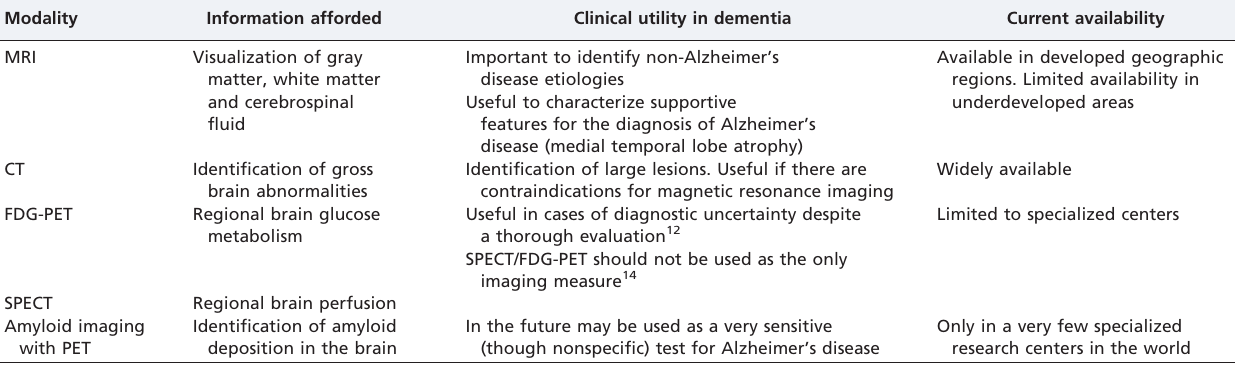
Table 1 - Neuroimaging modalities in patients with suspected Alzheimer’s disease.